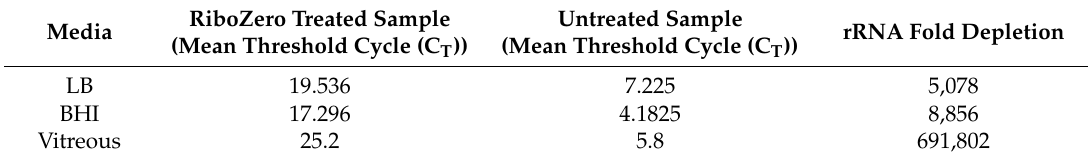
Table 1. Quantitative PCR assessing RiboZero depletion of 16s rRNA in B. cereus ATCC 14579.